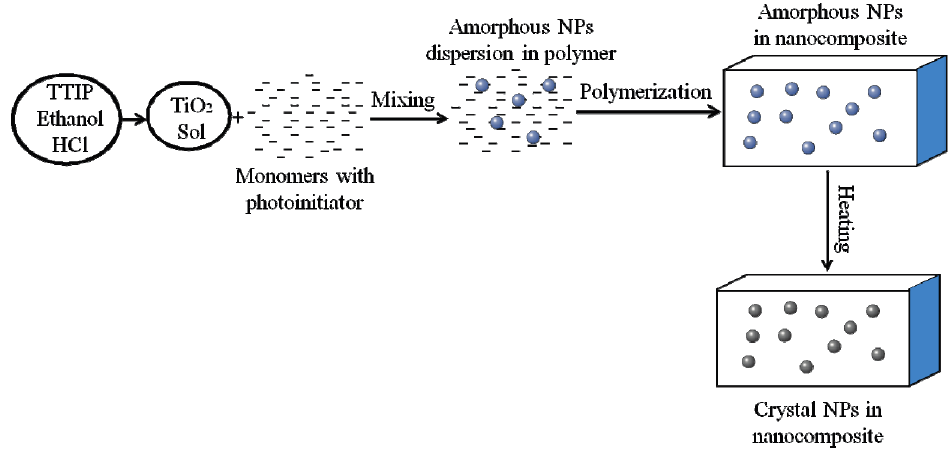
Figure 1. Schematic of in situ synthesis of nanoparticles in a polymer